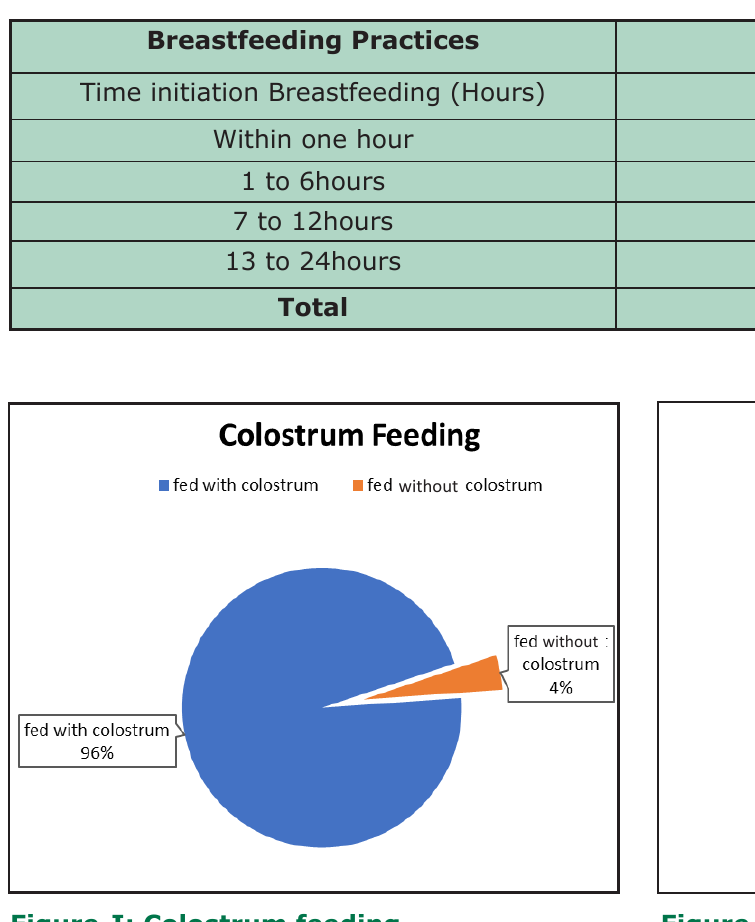
Figure-I: Colostrum feeding. Figure-II:Used of